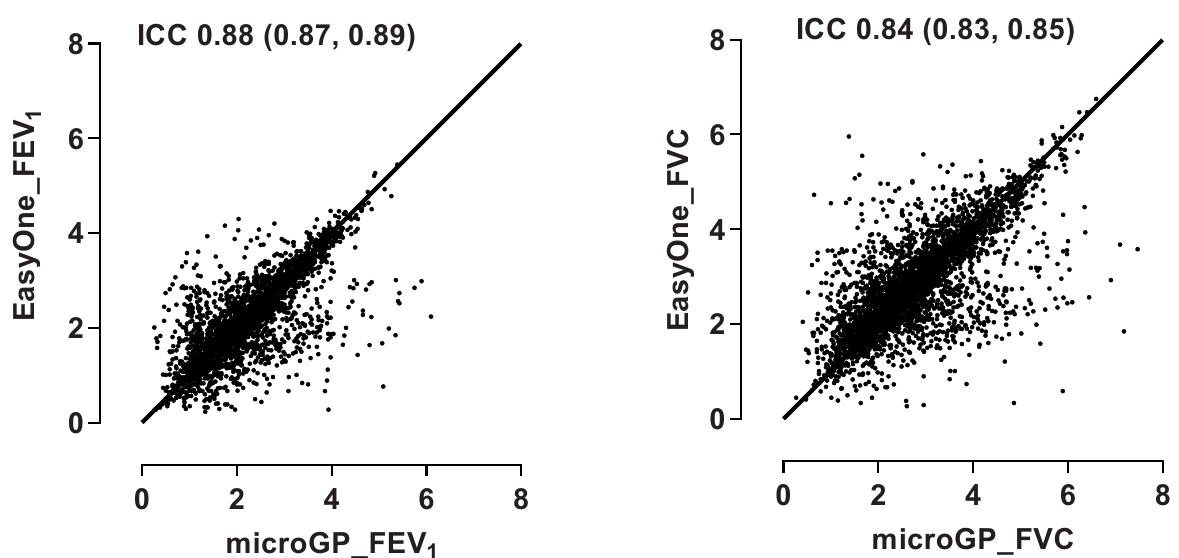
Fig 1. Overall correlation between paired FEV1 and FVC from the microGP and EasyOne spirometers. ICC = intraclass correlation coefficient and 95% CI for paired FEV1 (L) and FVC (L) measured within 3 hours and conducted in a random order. All measurements were supervised by the same trained study coordinator. The Line of identity is provide representing a perfect correlation between paired